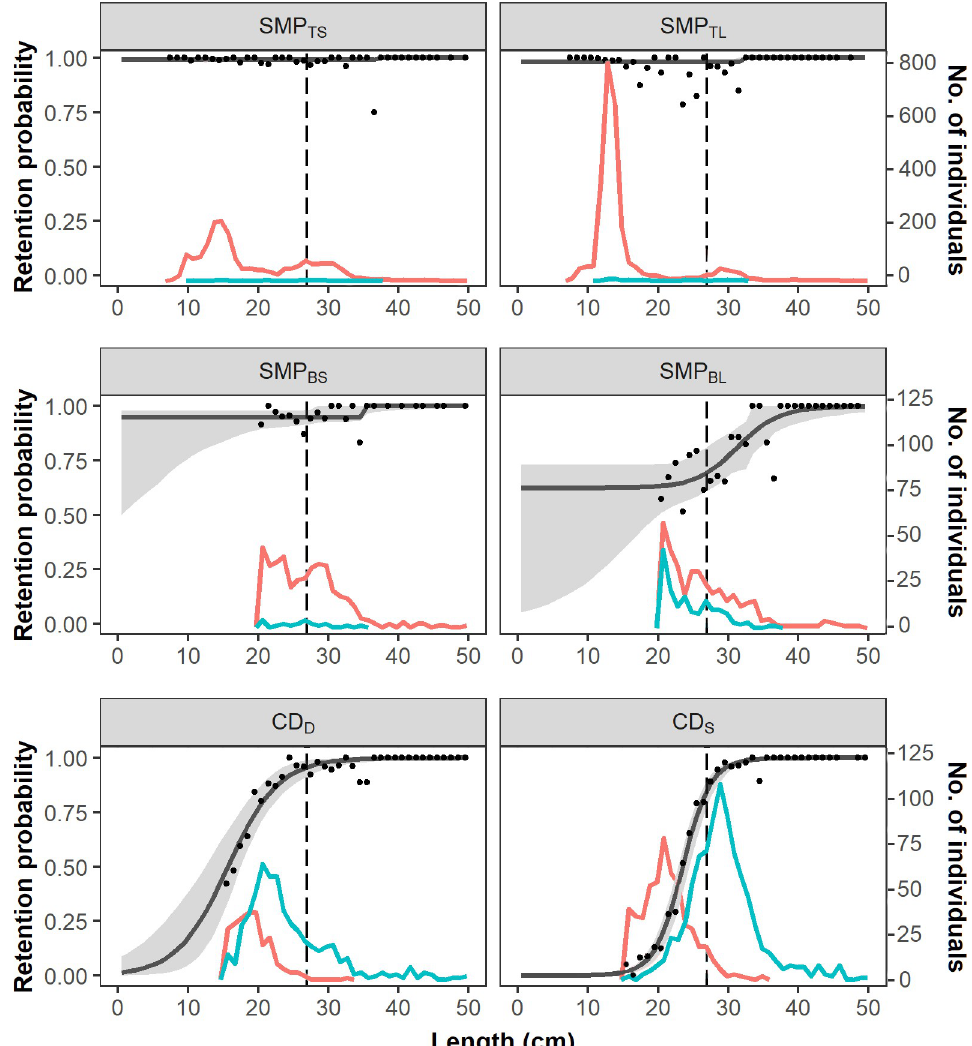
Fig 5. Length-dependent retention probabilities for hake. Retention probability curves (black line) with corresponding CIs (grey bands) and experimental rates (black dots) for the different SMP and codend configurations for hake. Vertical dashed lines show the MCRS for hake: 27 cm. The number of individuals escaped (red lines) and retained (blue lines) by each design are also shown.